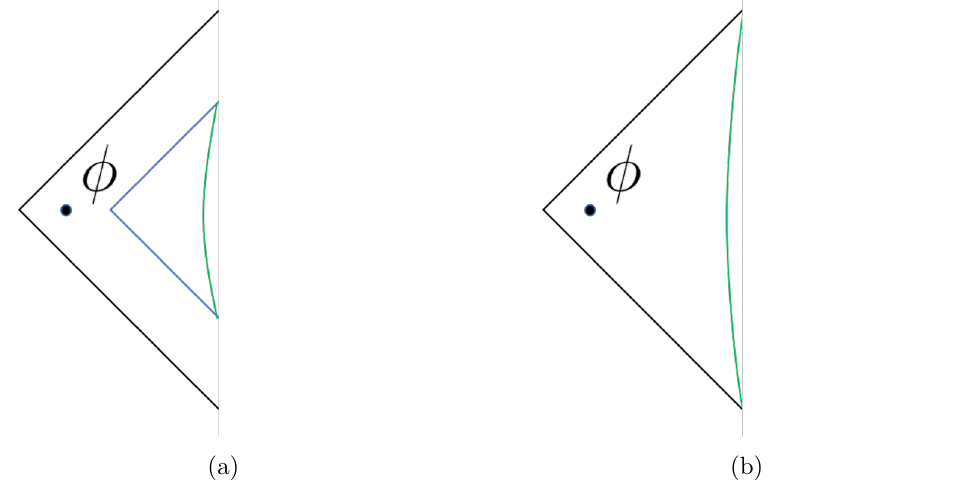
Figure 17. The states j B s ( (cid:12) ) i have a gravity description as a one sided black hole, ending on an end-of-the-world brane (black). If the system is evolved using the unperturbed SYK Hamiltonian, shown in (cid:12)gure 17a, the bulk operator (cid:30) lies behind the black hole horizon (blue). However if the Hamiltonian is perturbed in a state-dependent way, shown in (cid:12)gure 17b, the boundary (green) is pulled inwards and so the operator no longer lies behind a horizon. In the original construction, the Hamiltonian was precisely tuned for a single state j B s ( (cid:12) ) i . However one can easily adapt the Hamiltonian to work for a large set of